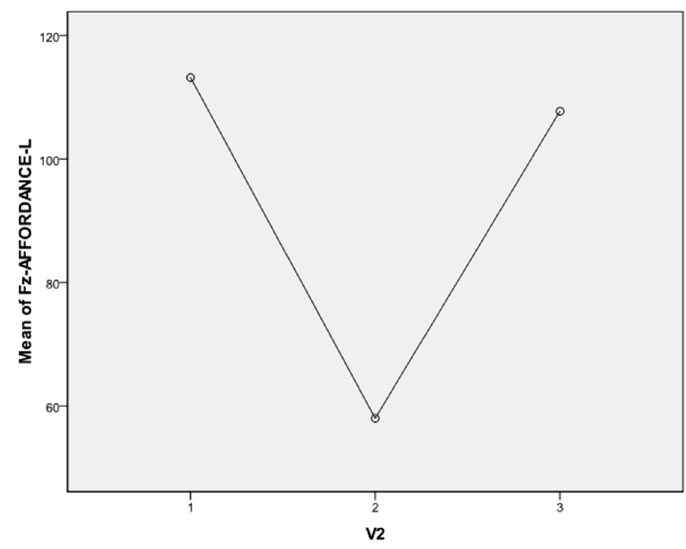
Figure 7. N1 ERP component latency in frontal lobe: condition 1 (motor imagery), condition 2 (Leap Motion), and condition 3 (haptic manipulation); in the Leap Motion condition N1 latency is faster. Sensors 2016 , 16 , 394